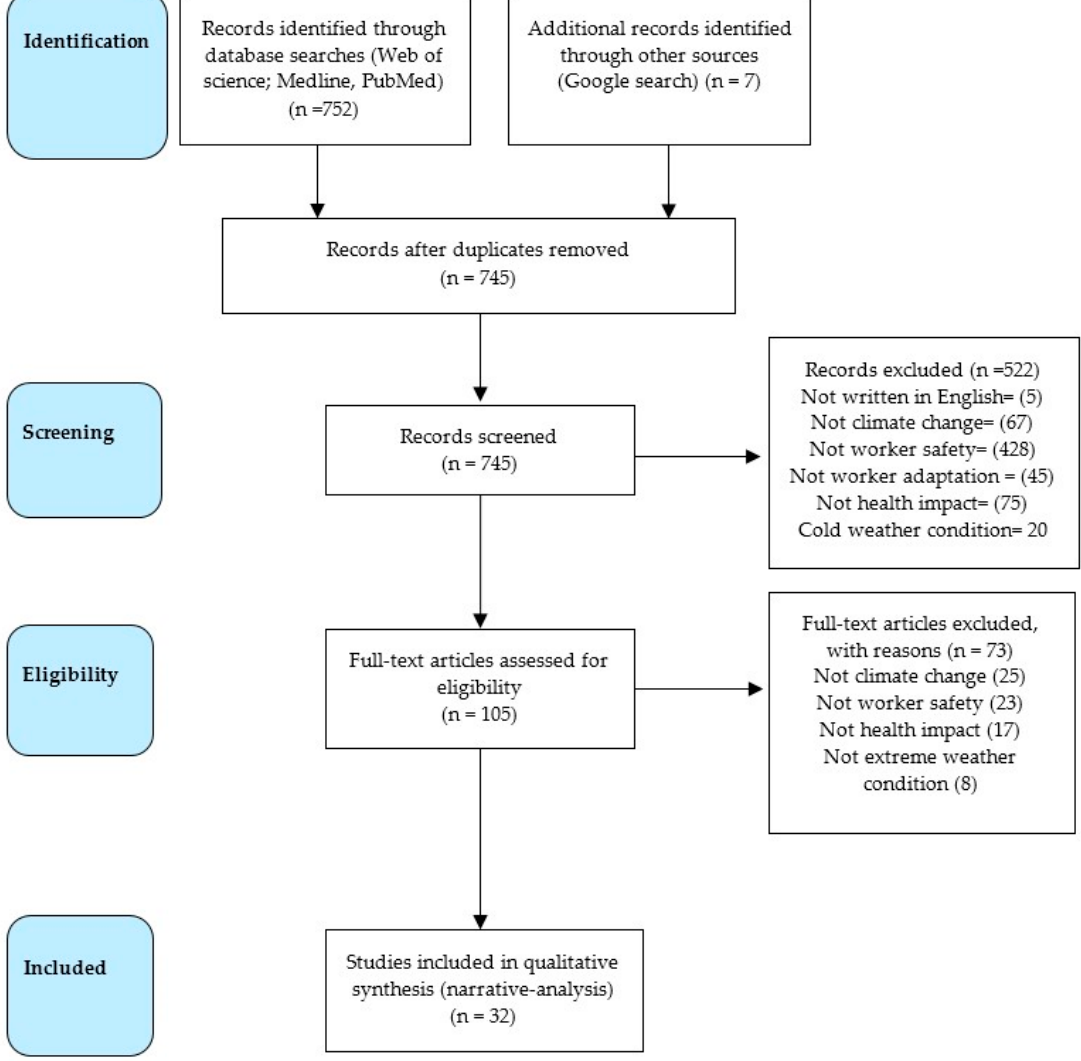
Figure 1. Adopted PRISMA flowchart providing insights as to how the studies were selected